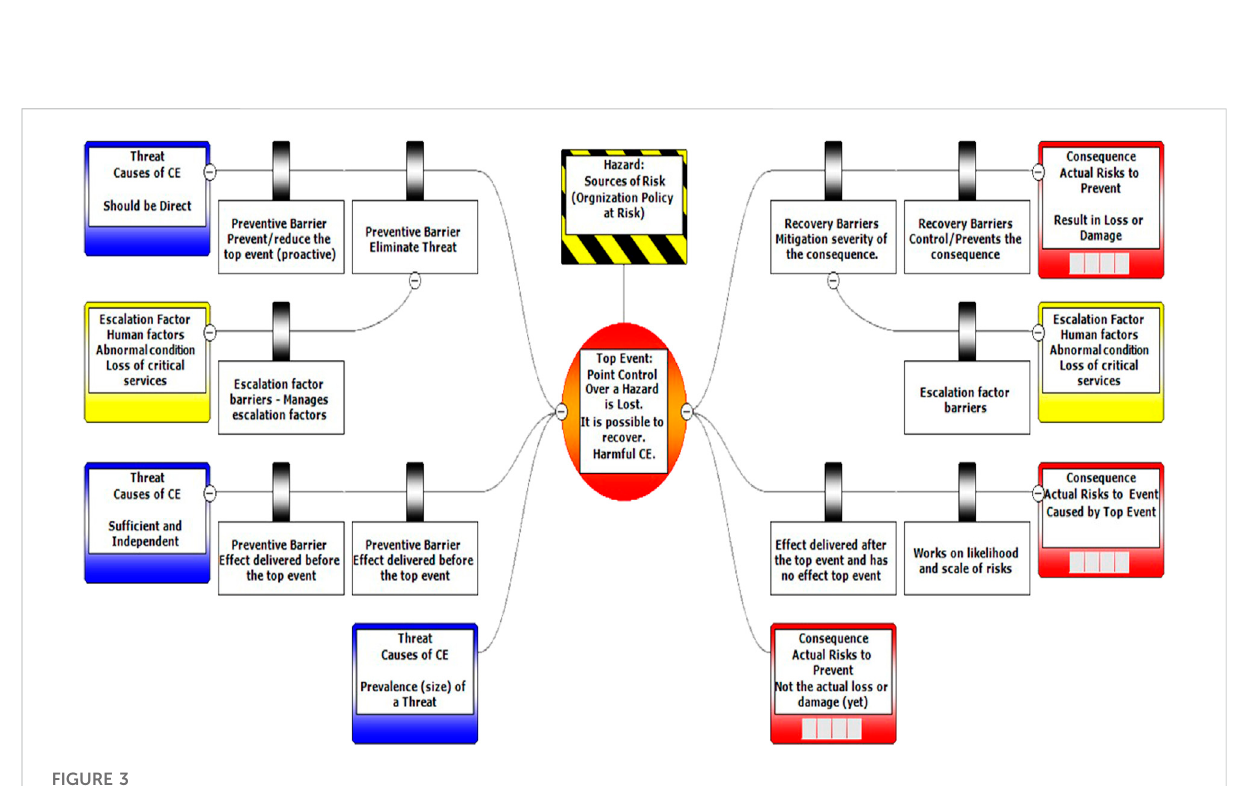
FIGURE 3 Components of a BRAT diagram.